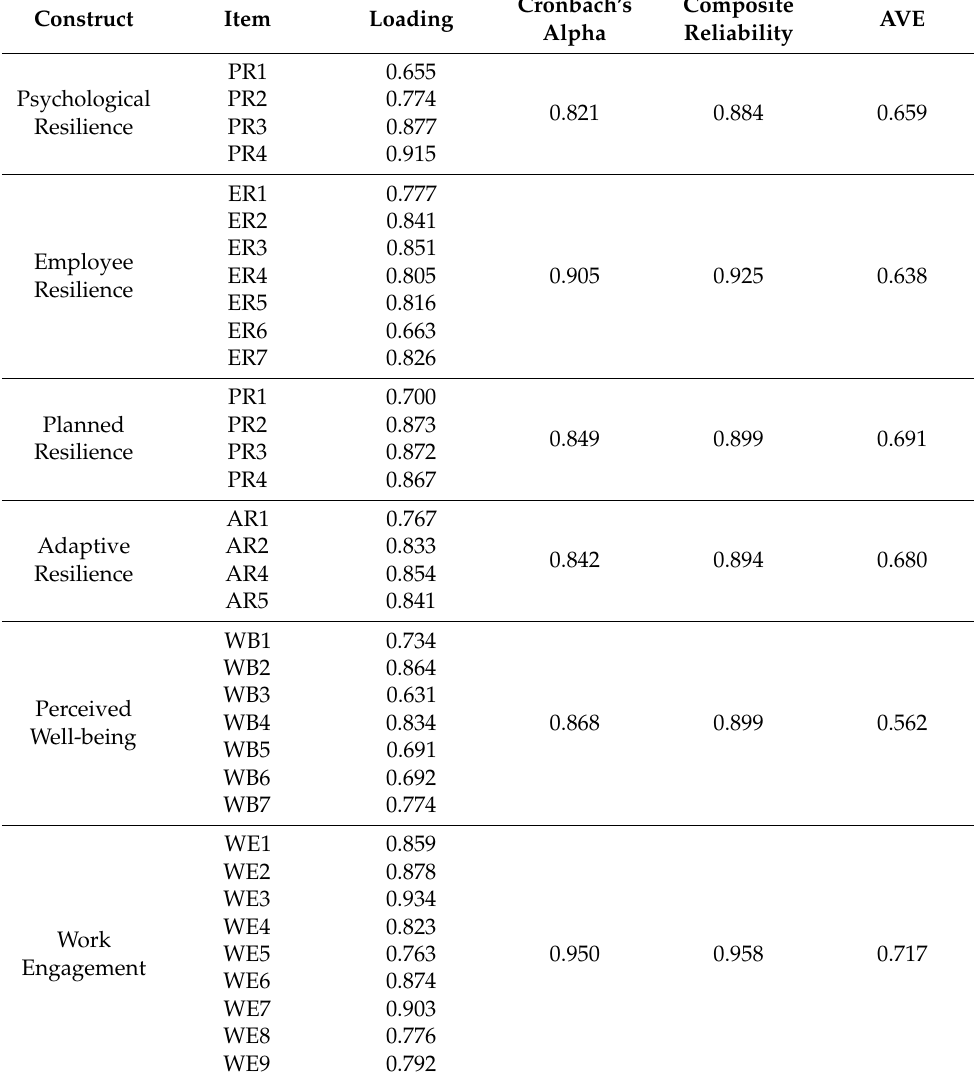
Table 2. Measurement Model Assessment.